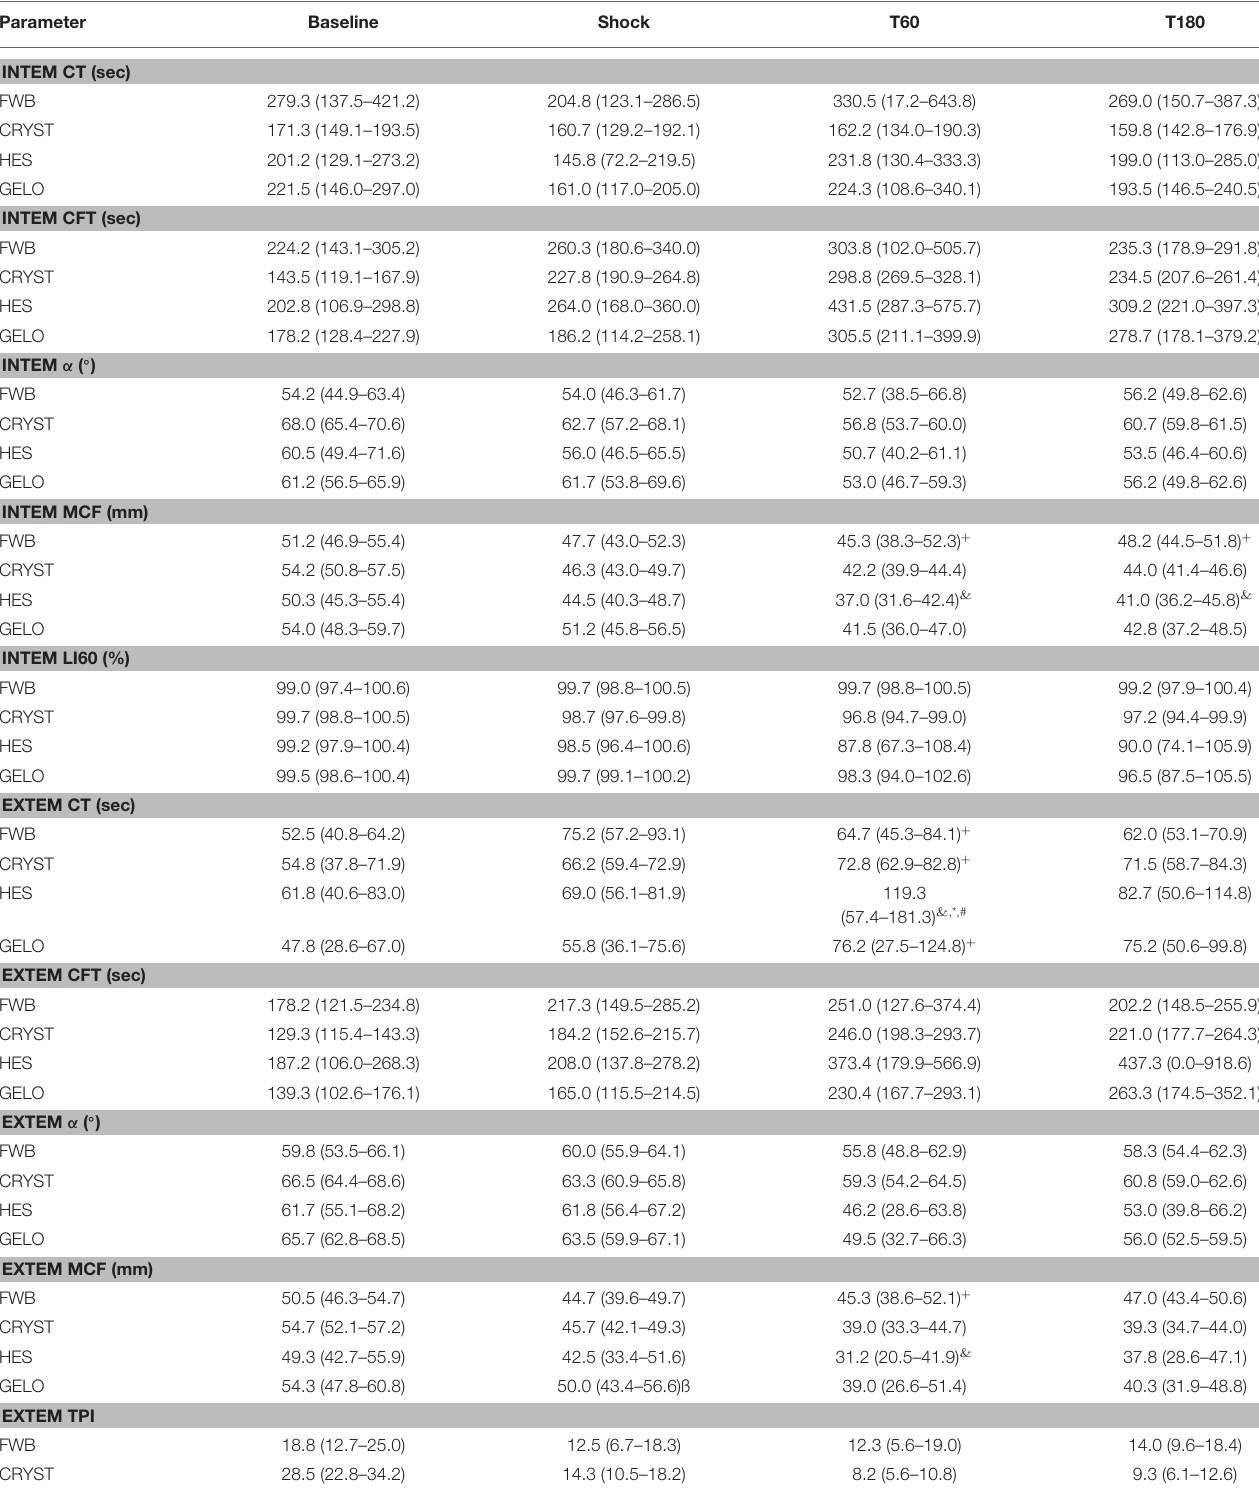
TABLE 2 | Rotational thromboelastometry parameters (mean, 95% confidence interval) in dogs ( n = 6 per group) with hemorrhagic shock given 20mL kg − 1 of either fresh whole blood (FWB), hydroxyethyl starch 130/0.4 (HES), 4% succinylated gelatin (GELO), or 80mL kg − 1 of balanced isotonic crystalloid (CRYST).